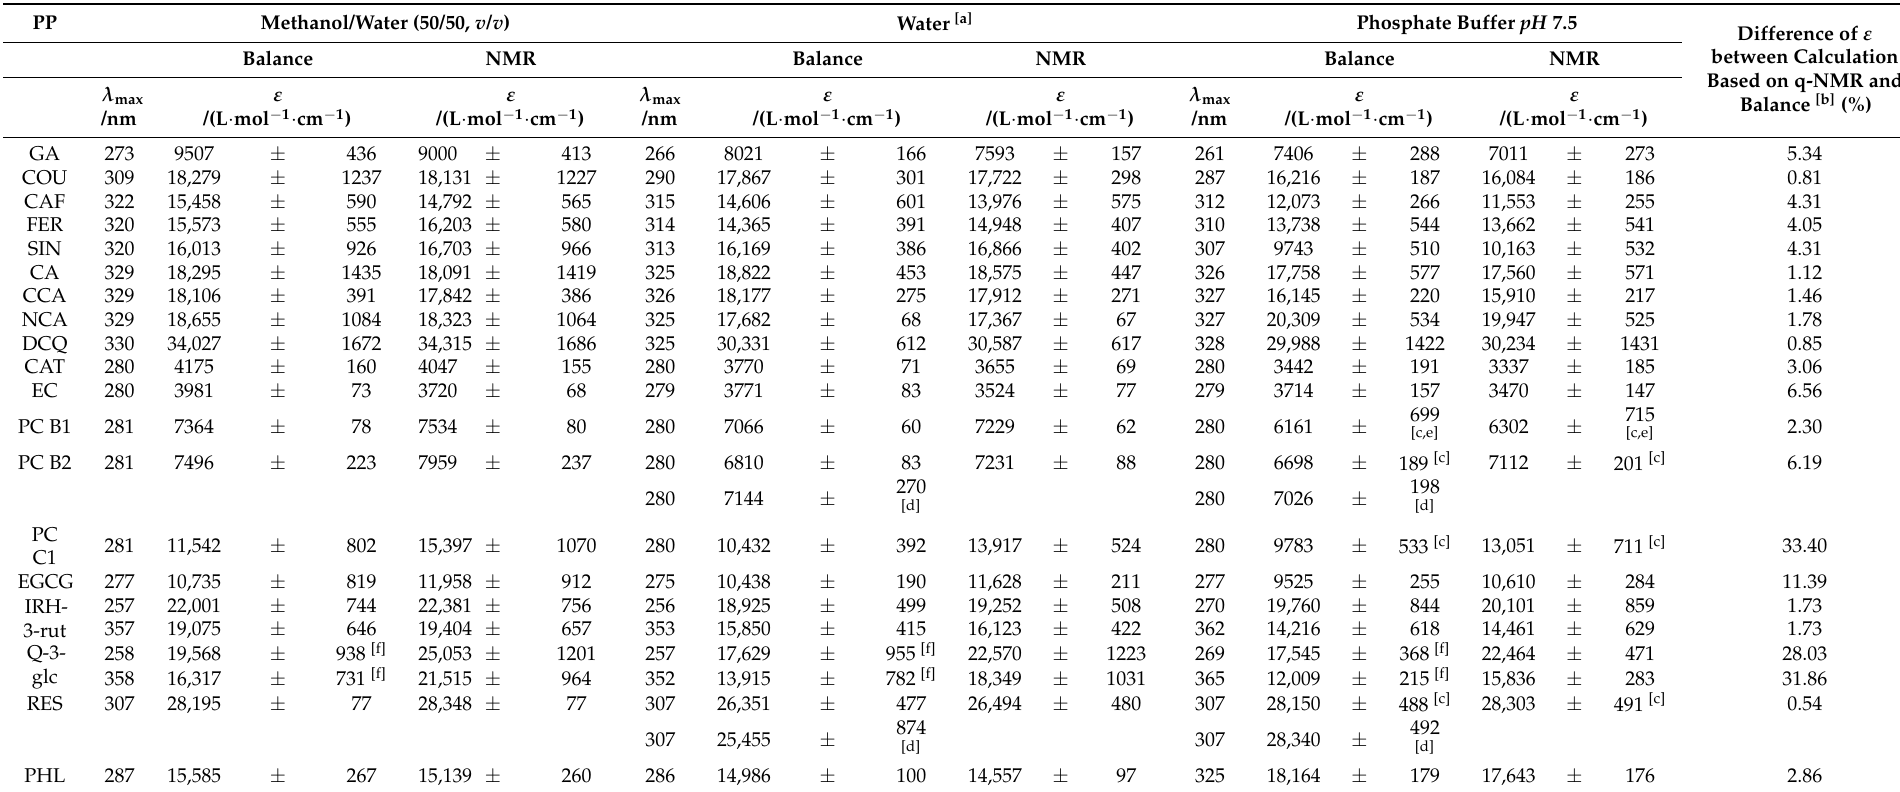
Table 1. Absorption coefficients at λ max (individual) for different phenolic compounds in methanol/water, water, and phosphate buffer pH 7.5 using concentrations determined by balance and